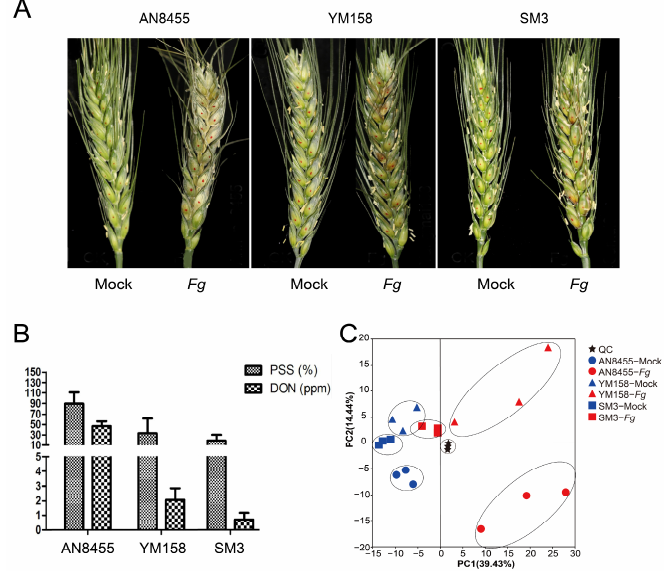
Figure 1. Resistance to F. graminearum is variety-dependent. ( A ) A representative picture of mock- and Fg -inoculated wheat heads belonging to three wheat cultivars: AN8455, YM158, and SM3. Pictures were taken 4 days post-inoculation. ( B ) Percentage of scabbed spikelets (PSS) and deoxynivalenol (DON) content in infected spikelets of different wheat varieties. ( C ) Principal component analysis (PCA) diagram of detected metabolites. The stars represent quality controls (QC). Red indicates samples with Fg treatment, and blue indicates mock inoculated samples.